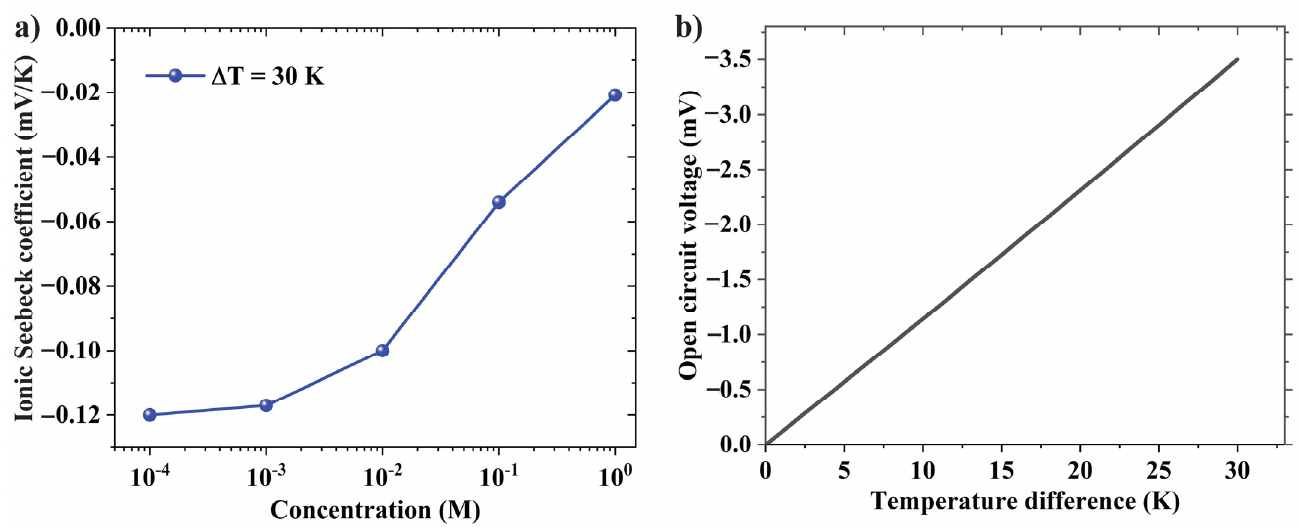
Figure 4. ( a ) Effect of electrolyte concentration on Seebeck coefficient. ( b ) Linear relation between open-circuit voltage and temperature difference.